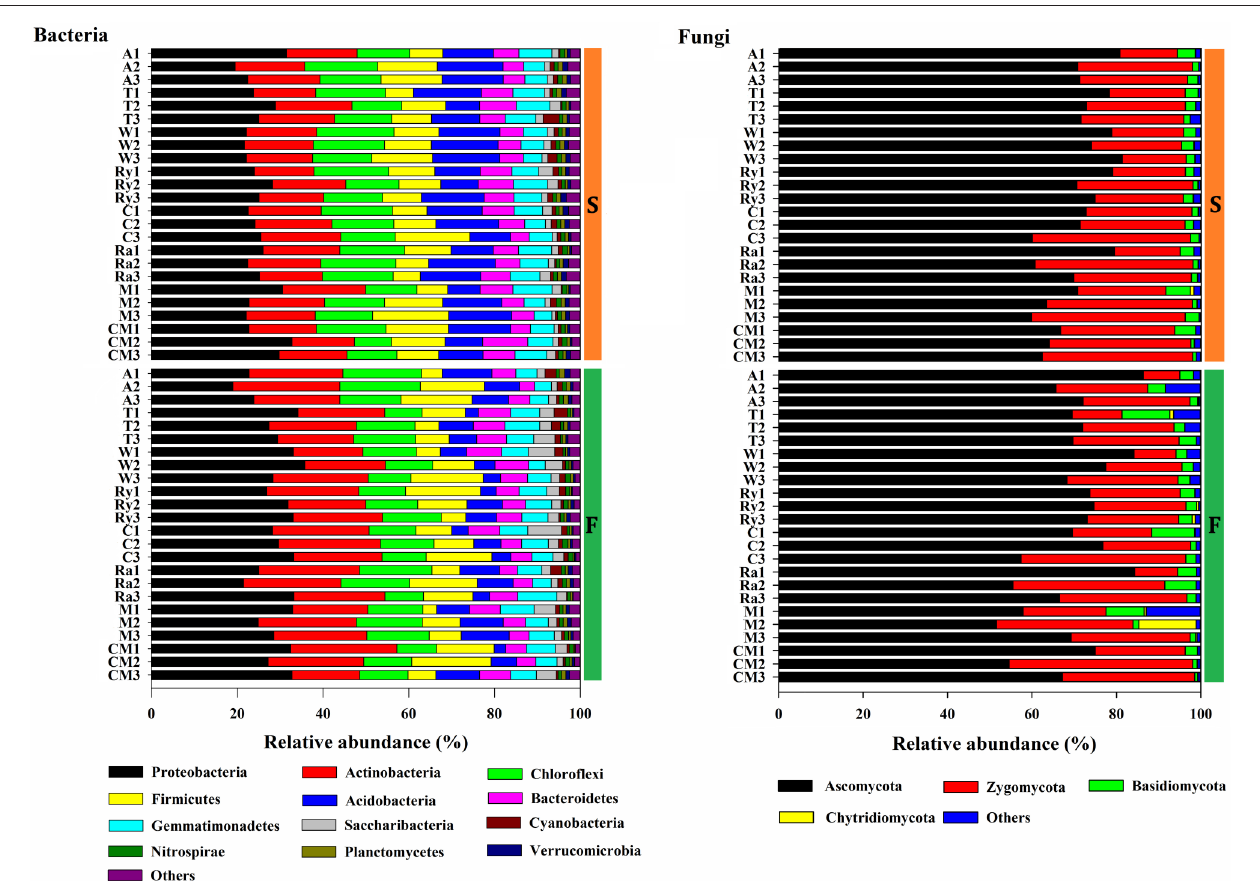
FIGURE 2 | Changes in the relative abundances of bacterial and fungal phyla under different treatments in the spring (S) and fall (F) cropping seasons. Others includes phyla below 0.1% of relative abundance and the unclassified phyla.